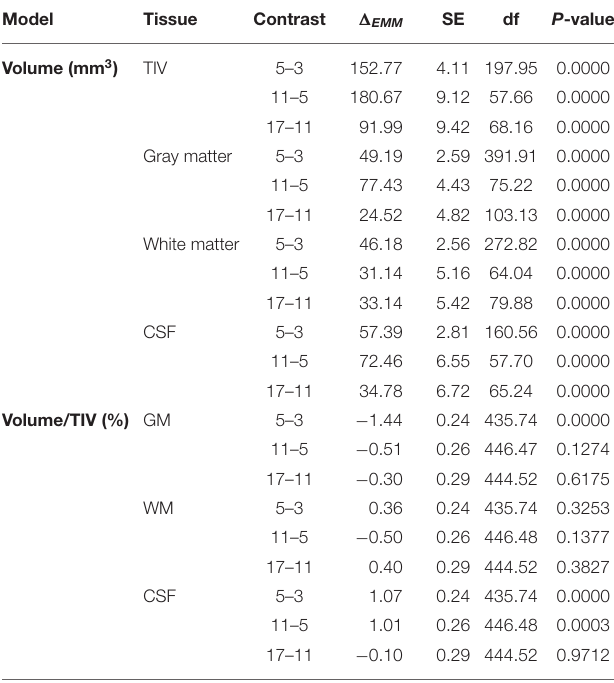
TABLE 1 | Consecutive comparison of the Estimated Marginal Means (EMMs) of the linear mixed-effects models.